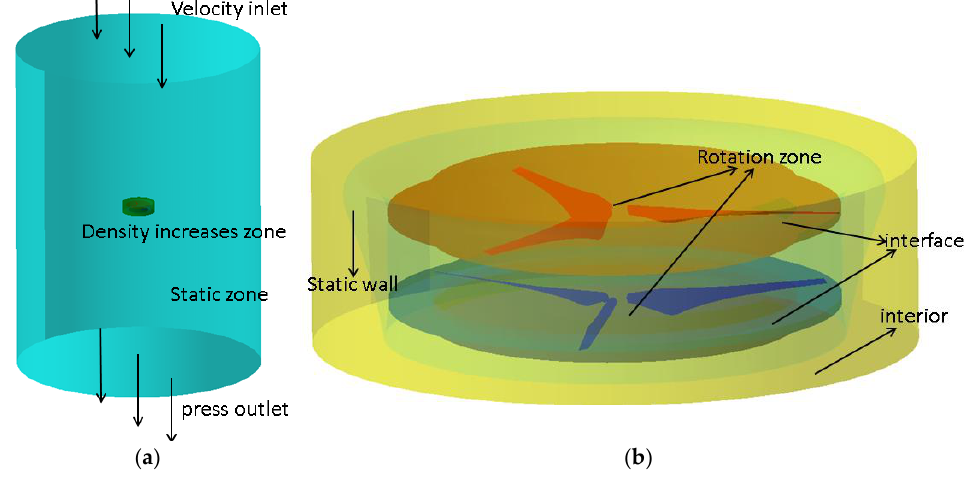
Figure 3. Boundary conditions: ( a ) static zone; ( b ) rotation zone.